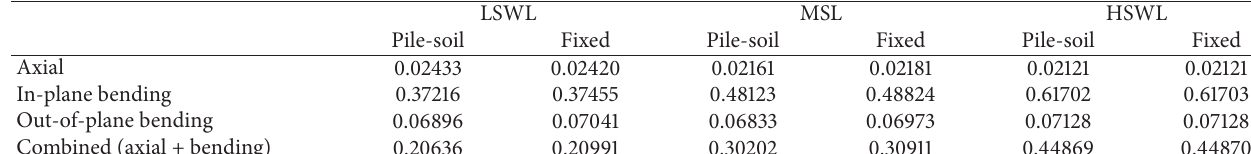
Table 18: Joint unity checks for irregular wave.